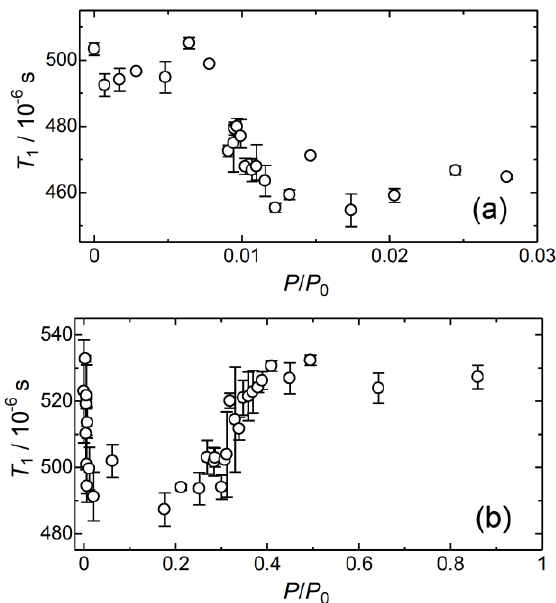
Figure 3. 1 H T 1 as a function of the relative pressure of CO 2 under sorption equilibrium with ELM-11 at: ( a ) 273 K and ( b ) 195 K.